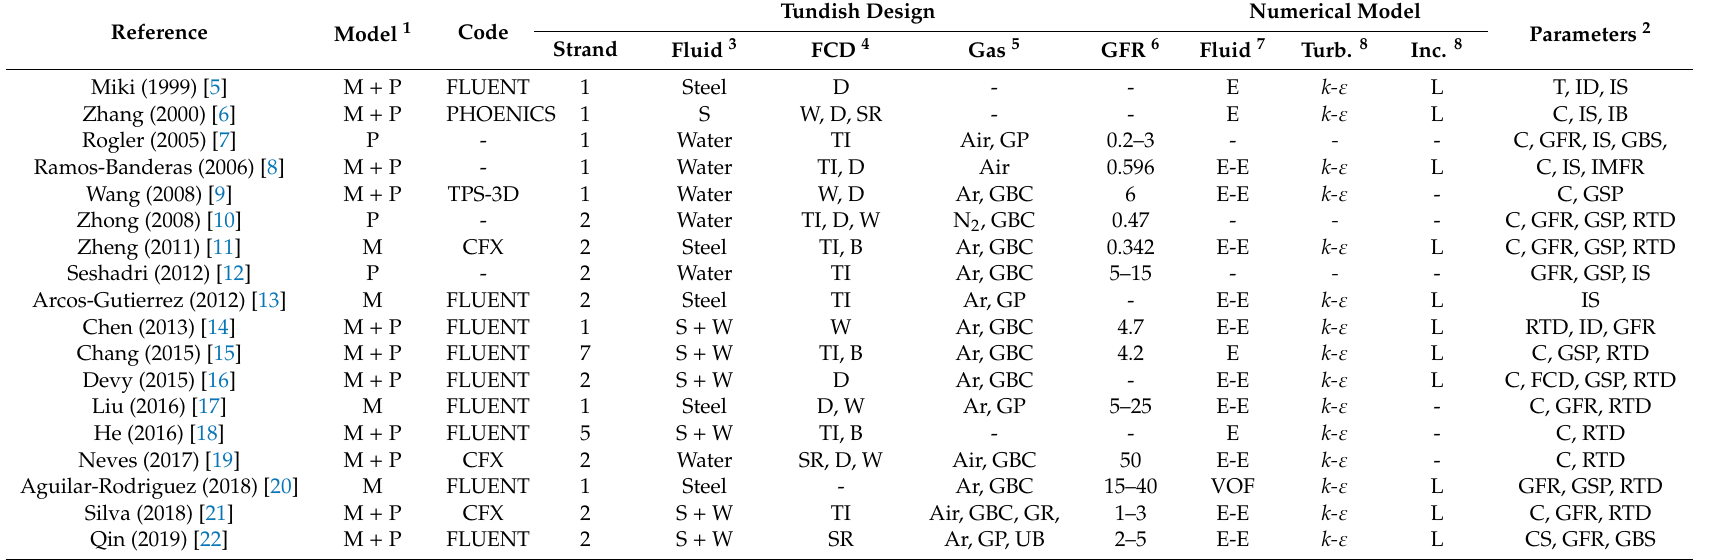
Table 1. Summary of modelling investigations on inclusion removal performance in the